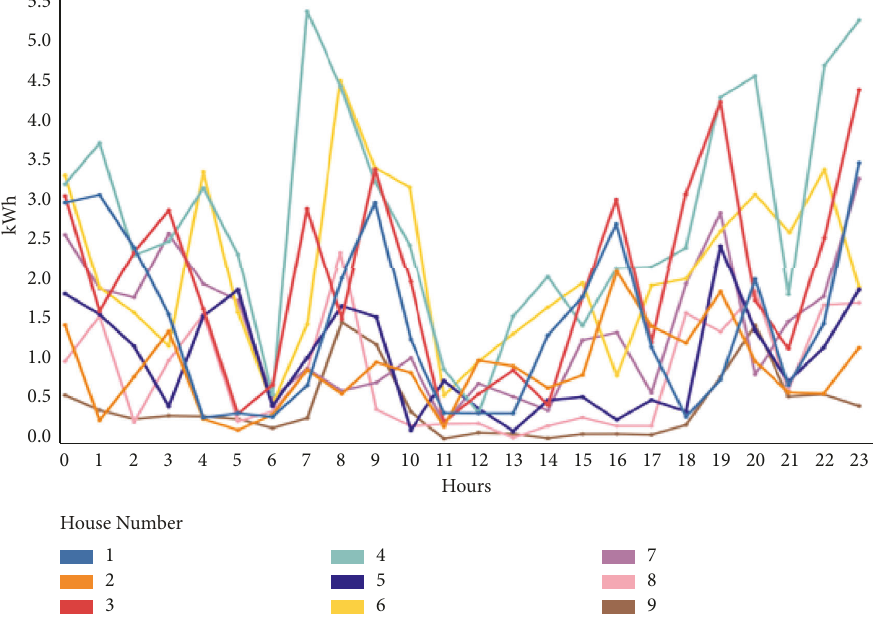
Figure 7: Average hourly load profiles of 9 consumers for one summer month,